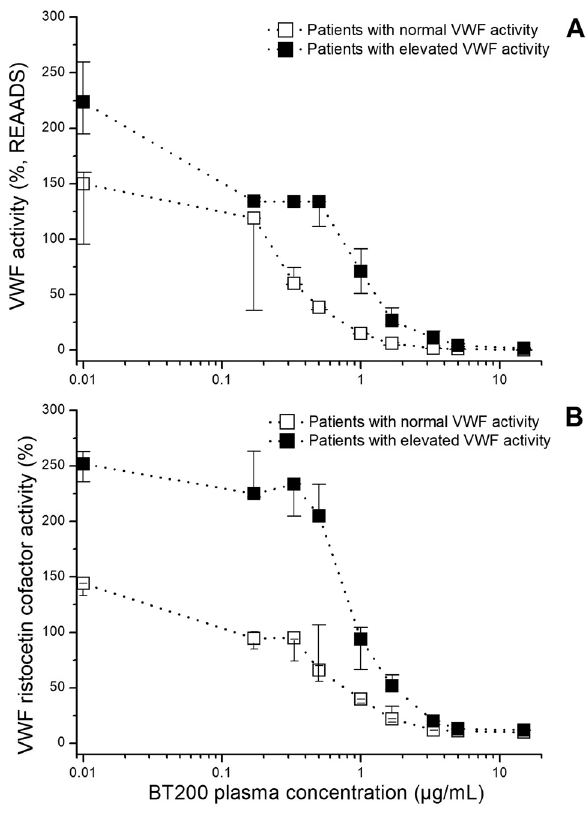
Figure 2. Target concentration dependent effects of BT200 on von Willebrand factor (VWF) activity ( A ) and VWF ristocetin cofactor activity ( B ) in patients with large artery atherosclerosis stroke or transient ischemic attacks when stratified into groups with normal (< 180%) or elevated (> 180%) VWF activity. Data are presented as median values and interquartile ranges and baseline is presented as 0.01 for better visualization on the log